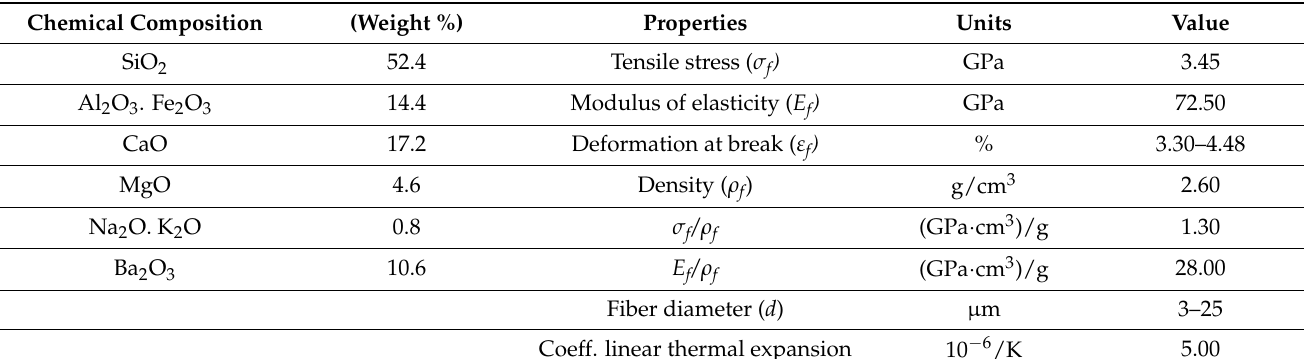
Table 1. Properties of E-glass fiber (G. Lubin, Handbook of composites.: Van Nostrand Rein- hold, 1983).